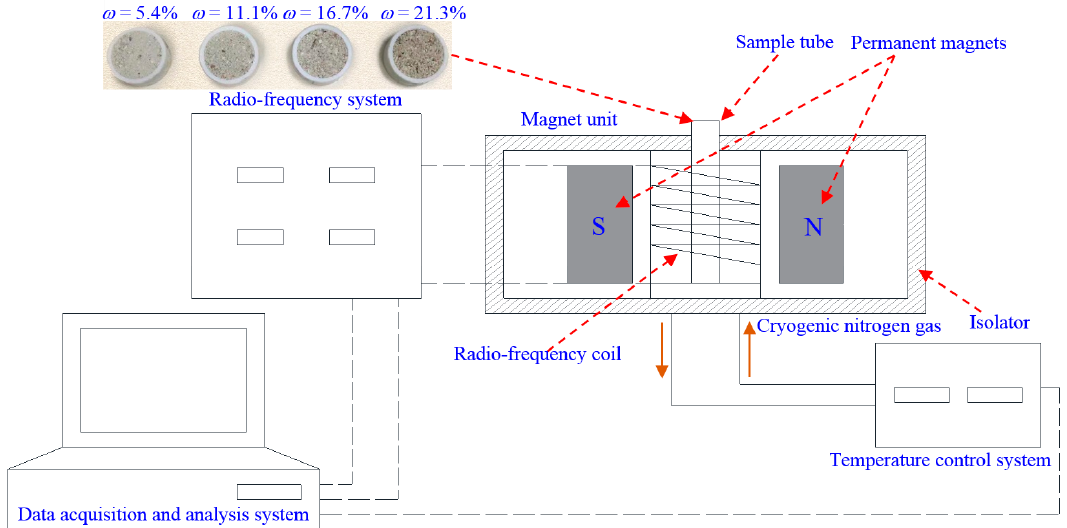
Figure 4. Schematic diagram of the PQ001 mini nuclear magnetic resonance analyzer and the sample tested.